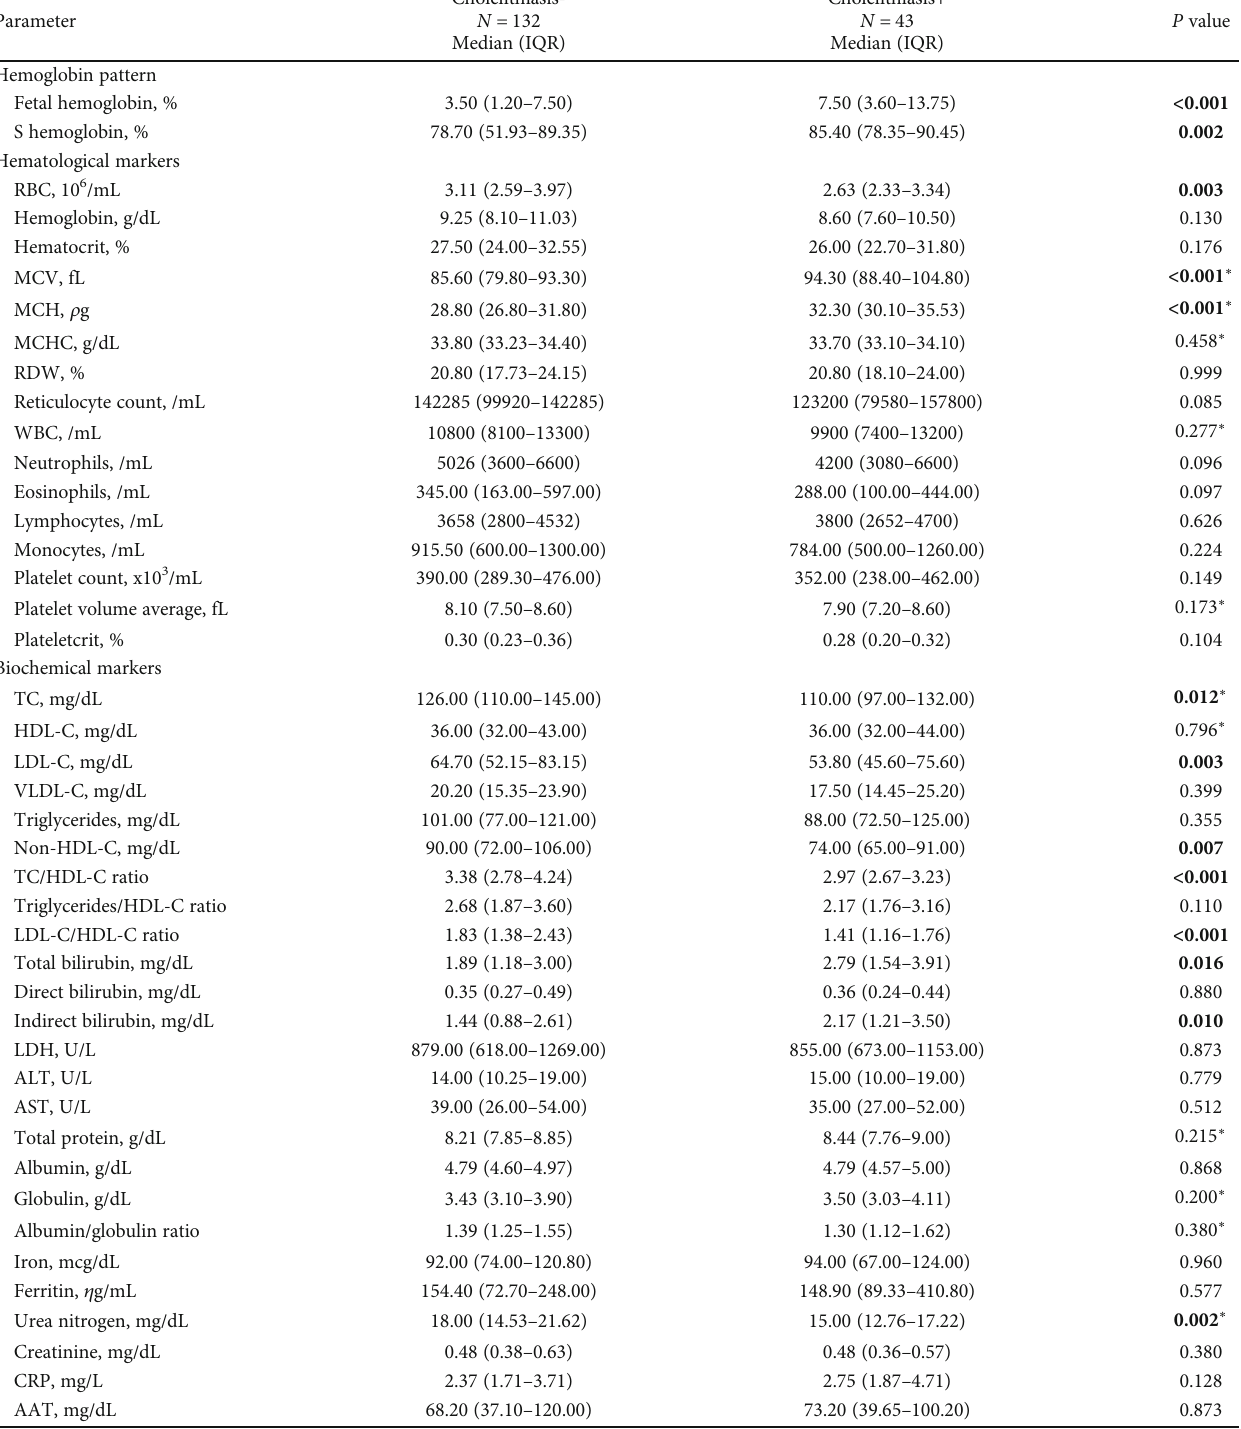
Table 9: Association of occurrence of cholelithiasis with laboratory